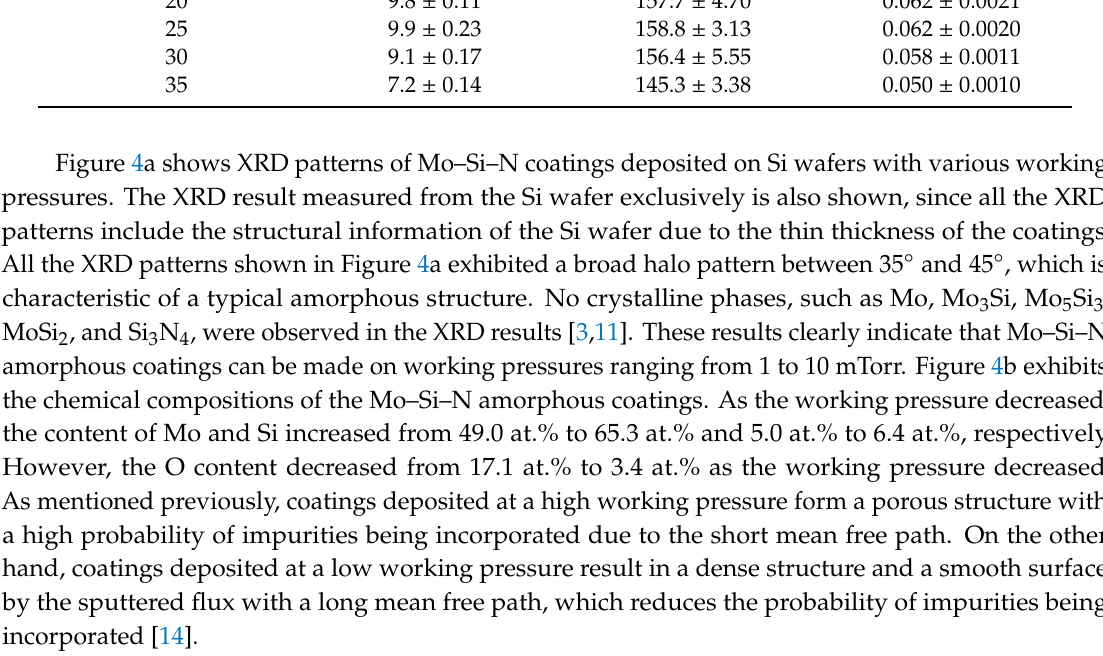
Table 2. Hardness ( H ), elastic modulus ( E ), and H / E ratios of the Mo–Si–N coatings deposited at N 2 gas flow ratios from 10% to 35%, retaining the working pressure of 10 mTorr.